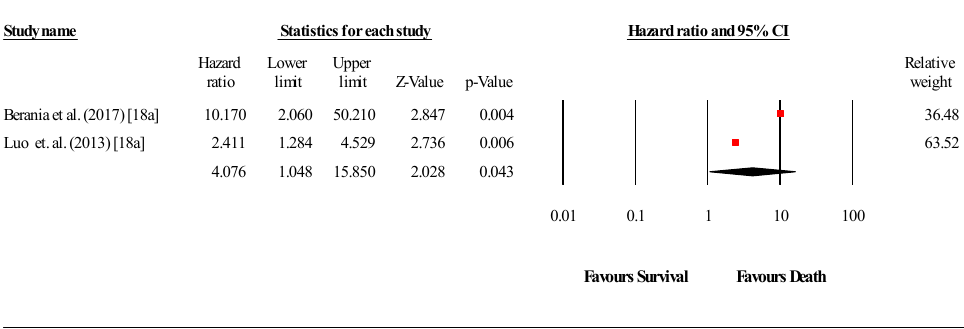
Figure 8. Forest plot for miR-34c-5p association with OS.